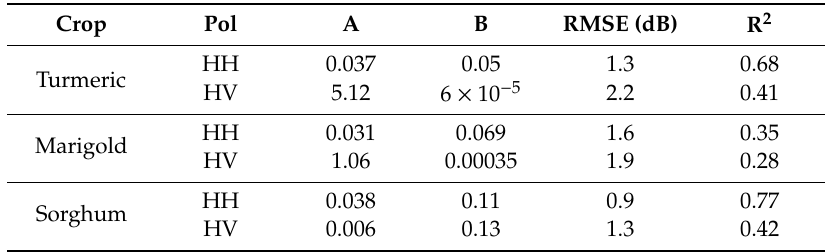
Table 2. Water cloud model (WCM) parameters for di ff erent crops and polarizations, and RMSE between the calibrated model and the observed